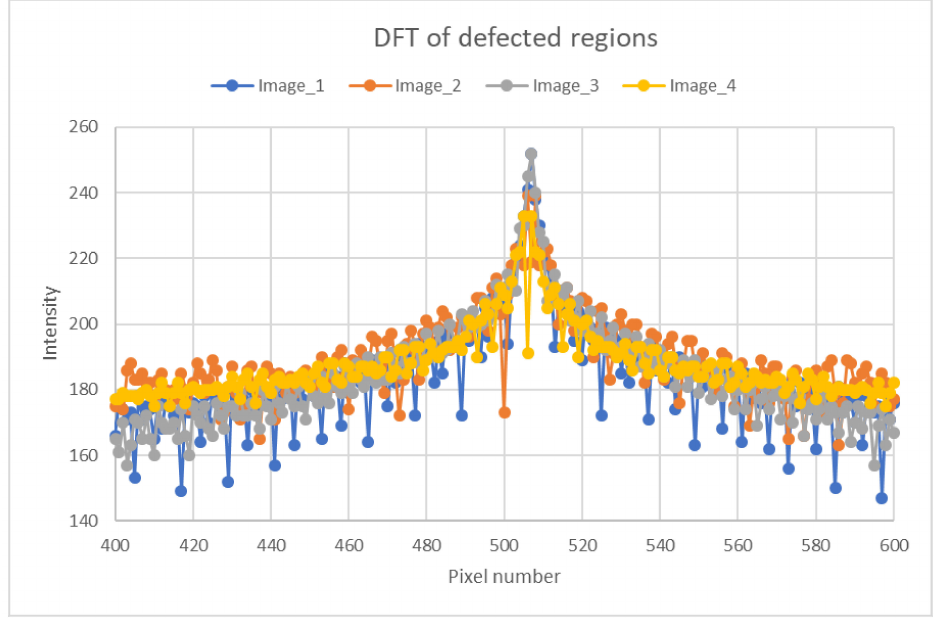
Figure 15. Comparison of DFT amplitude profile of the images shown in Figure